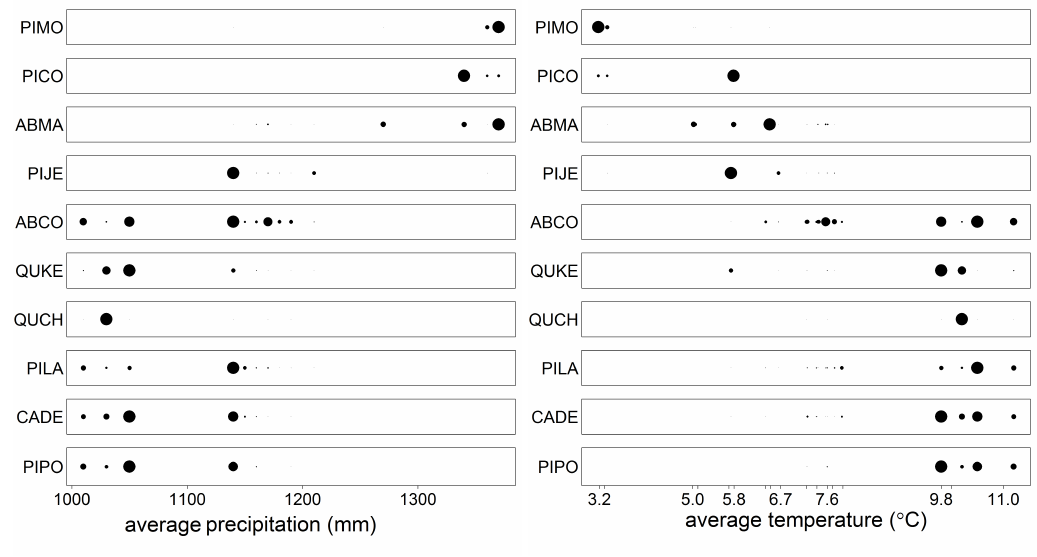
Figure 4. Range of plot average precipitation and temperature for the different species. Presence of trees for each species and each value of precipitation ( left ) and average temperature ( right ). The point sizes are proportional to the abundance of the species in the relevant